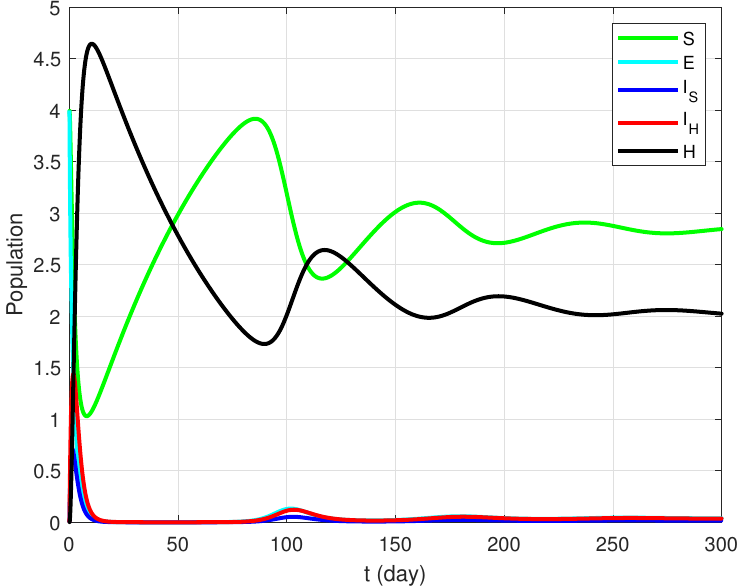
Figure 2. The dynamics of all classes when we set the parameters α = 0.8 and η = 0.5. The endemic point P ∗ is asymptotically